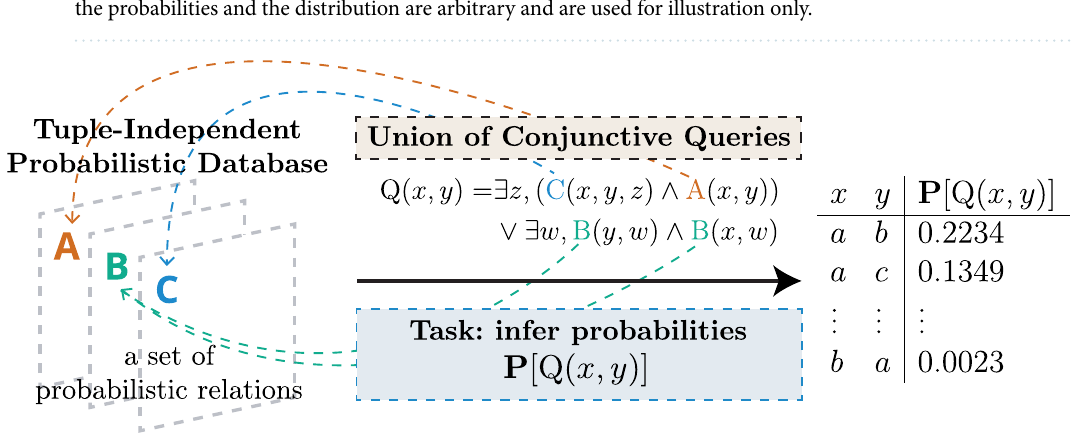
Figure 8. Solving a union of conjunctive queries on a tuple-independant